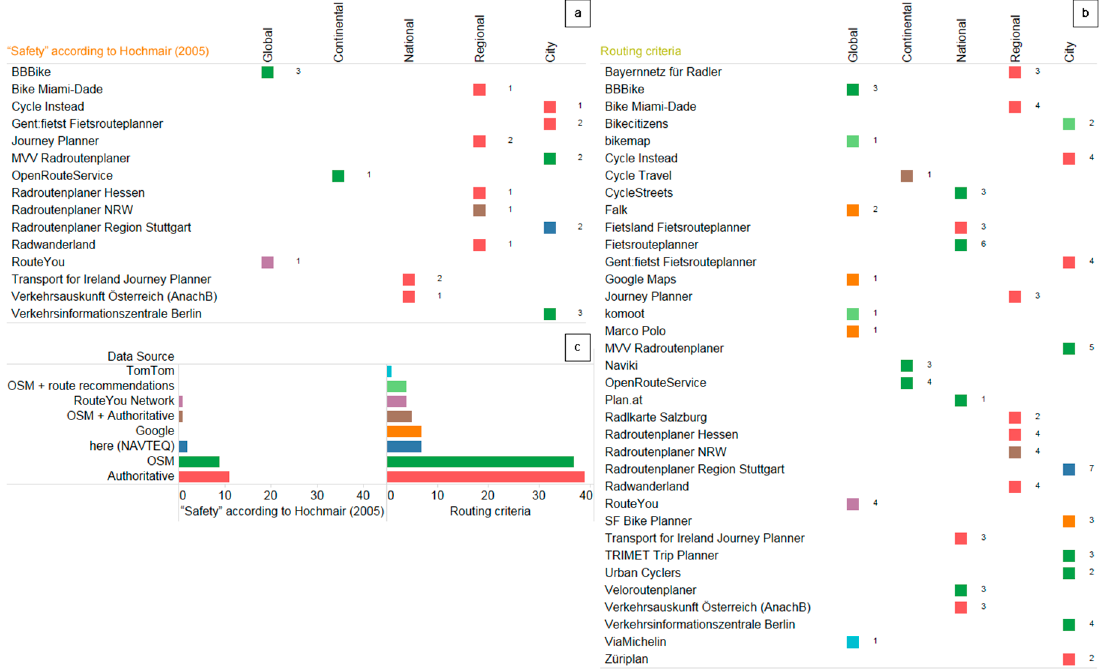
Figure 4. Factors that contribute to the routing criterion “safety” according to Hochmair [19] (orange), and general routing criteria (green). Both classes are mapped onto the analyzed portals in the matrix to the right.